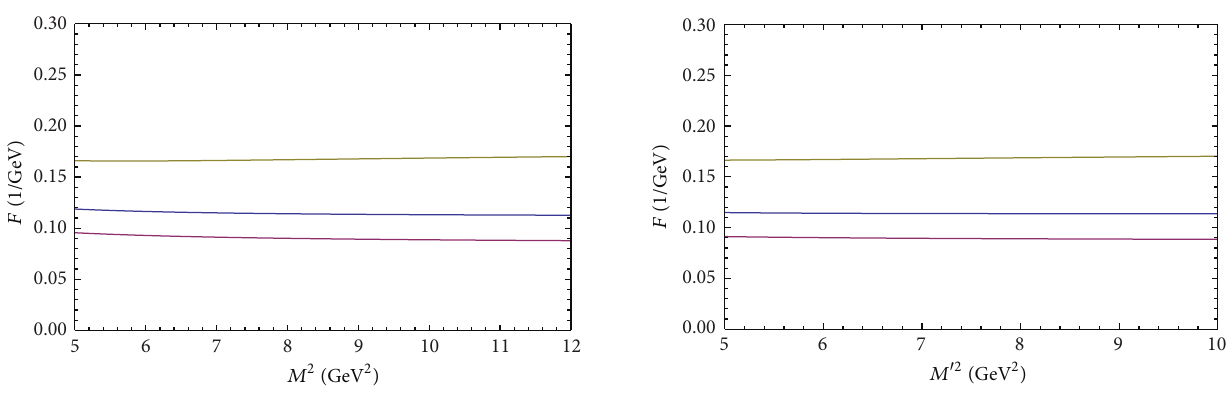
Figure 4: The dependence of the 𝐹(𝑞 2 = −10) on 𝑀 2 for three different values of 𝑠 0 = 13.8, 14.54, 16.11 , 𝑠 󸀠 0 = 11.56, 12.25, 13.69 , and 𝑀 󸀠2 = 6 for the 𝜒 𝑐0 → 𝐽/𝜓𝛾 decays. The green, blue, and purple lines are for minimum, central, and maximum values of 𝑠 0 and 𝑠 󸀠 0 .